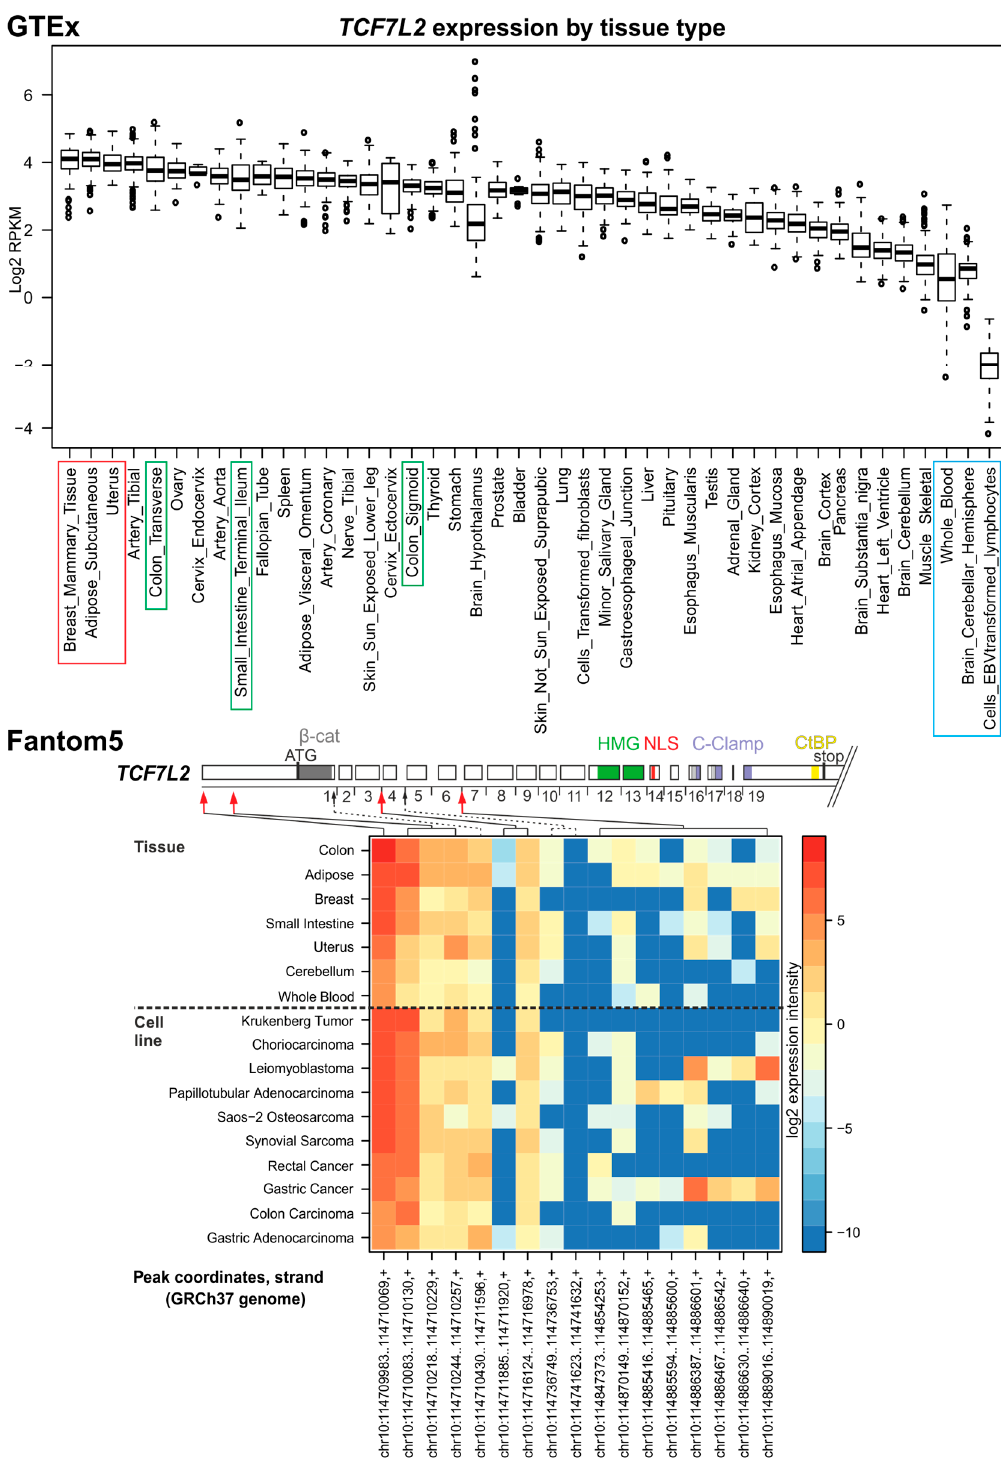
Figure 5. TCF7L2 expression in human tissues and TSS usage. For description, see Figure 2 legend.